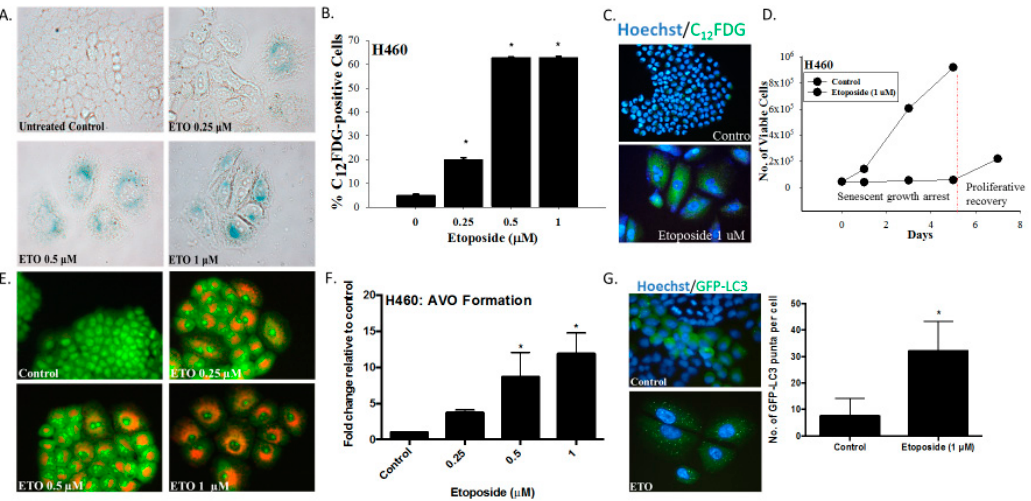
Figure 1. The induction of senescence and autophagy in H460 cells in response to etoposide. ( A ) Senescence-associated β -galactosidase staining of H460 cells exposed to etoposide (0.25, 0.5, or 1 µM) 48 h after drug removal (20x objective). ( B ) Quantification of senescence based on C 12 FDG staining of H460 cells followed by fluorescence-activated cell sorting (FACS) analysis. ( C ) Widefield fluorescent microscopy showing C 12 FDG staining. Nuclei stained with Hoechst 33342 (20x objective). Staining and analysis were performed 48 h after drug removal ( D ) Growth arrest and proliferative recovery of H460 cells exposed to etoposide (1 µ M) for 24 h (day 0). ( E ) Fluorescence microscopy showing concentration-dependent increase in acridine orange-stained vacuoles induced by 0.25, 0.5, and 1 µM etoposide (20x objective). ( F ) Quantification of acidic vesicular organelles (AVOs) by FACS analysis in response to increasing concentrations of etoposide. ( G ) Fluorescence microscopy showing increased GFP-LC3 puncta in response to etoposide (1 µ M) exposure. Imaging performed 48 h after drug removal. (20x objective). Quantification of GFP-LC3 puncta formation in response to etoposide exposure. Results presented were from three independent experiments, unless otherwise indicated. * p < 0.05 compared to untreated controls.